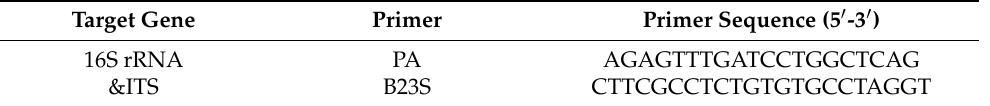
Table 1. Information on the primers PA and B23S used in this